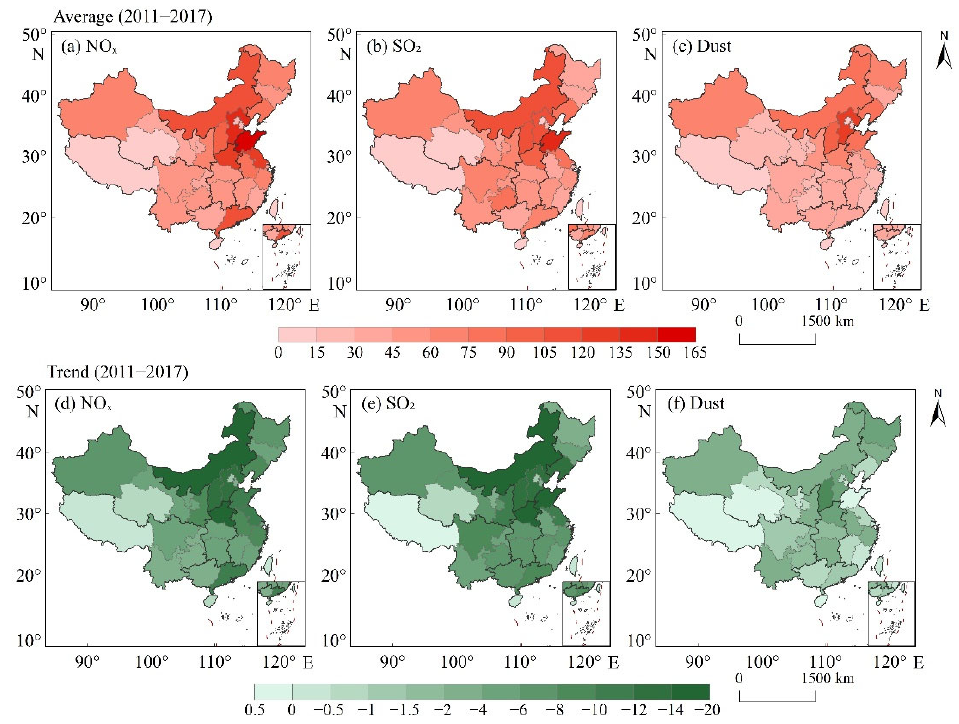
Figure 3. Spatial distribution of the ( a , b , c ) emissions of three air pollutants (NO x , SO 2 , and dust) in China (2011–2017) and ( d , e , f ) trend values for provincial units.